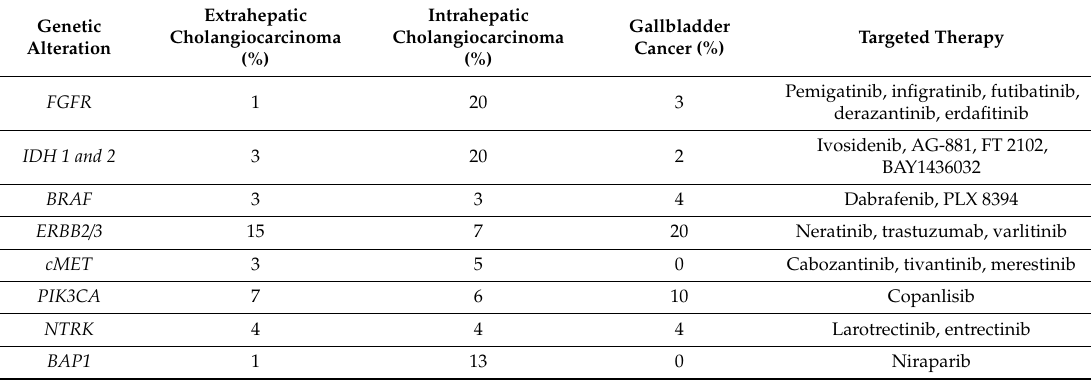
Table 1. Prevalence of therapeutically relevant genetic alterations in patients with advanced biliary tract cancer and the corresponding targeted therapies [27].